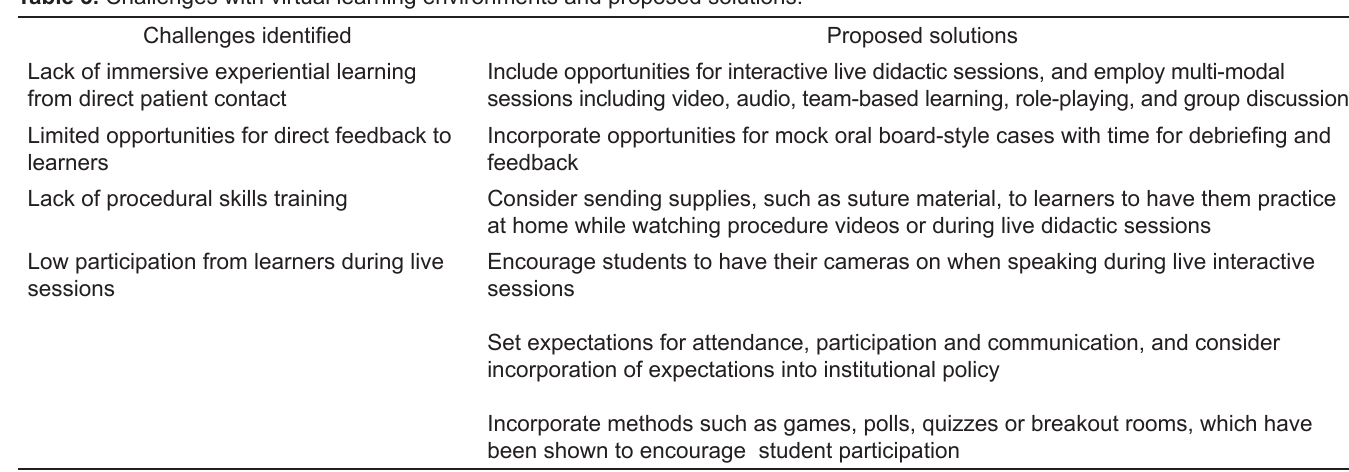
Table 3. Challenges with virtual learning environments and proposed